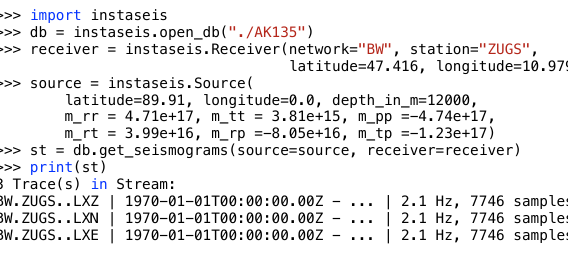
Figure 12. The Instaseis Python API demonstrated in a short in- teractive Python session. A Source and a Receiver object are created and then passed to the get_seismograms() method of an InstaseisDB object. This will extract the Green’s functions from the databases and perform all necessary subsequent steps re- sulting in directly usable three-component seismograms in form of an ObsPy Stream object. Please refer to the Instaseis documenta- tion for